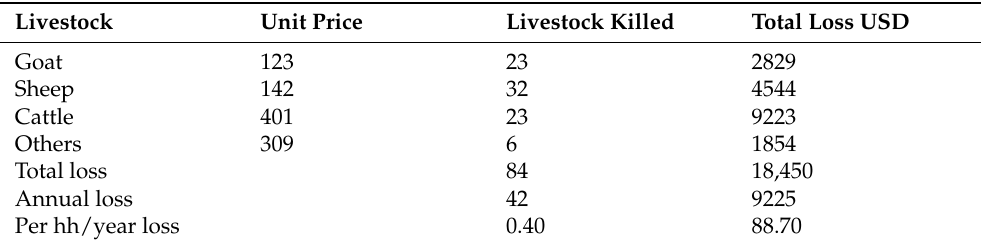
Table 1. Details of livestock predation and suffered economic losses due to the grey wolf in Kumrat Valley (2020,